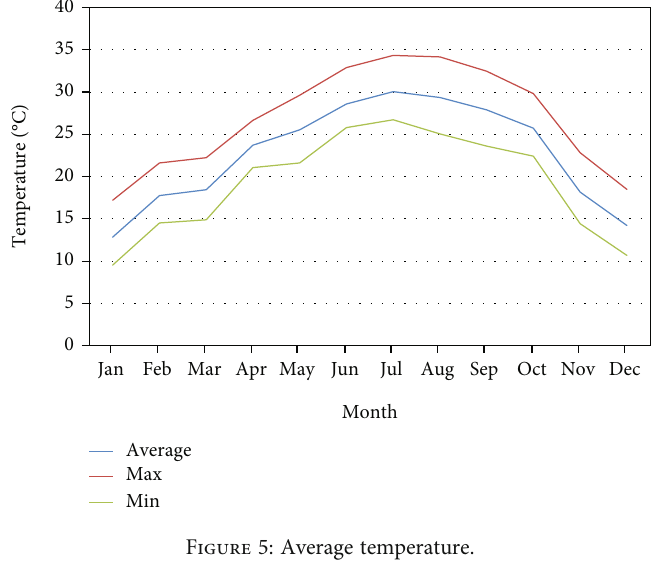
Figure 5: Average